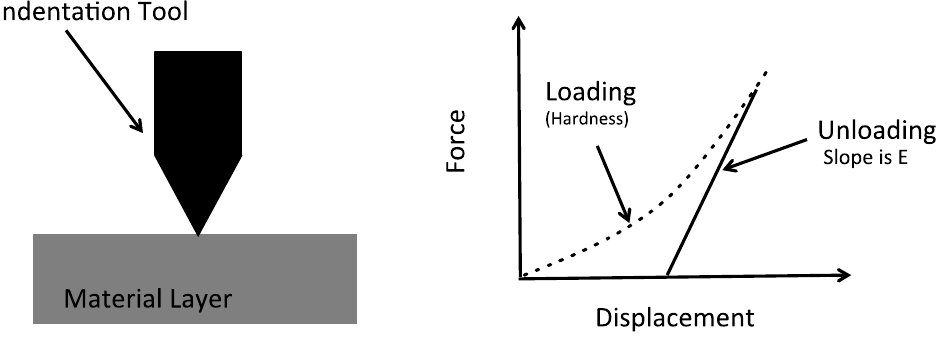
Figure 17. Nano-indentation used to measure modulus of material layer.